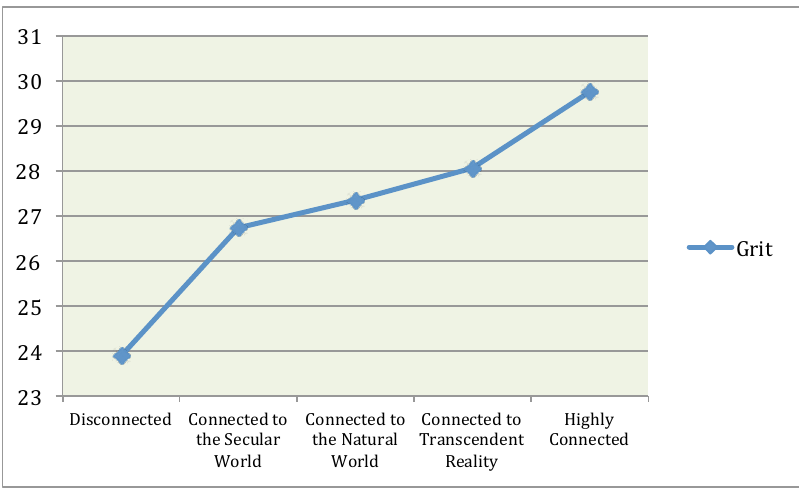
Figure 5. One-way ANOVA of mean gratitude across five classes of spiritual connection, F=47.5*. * p < .01.